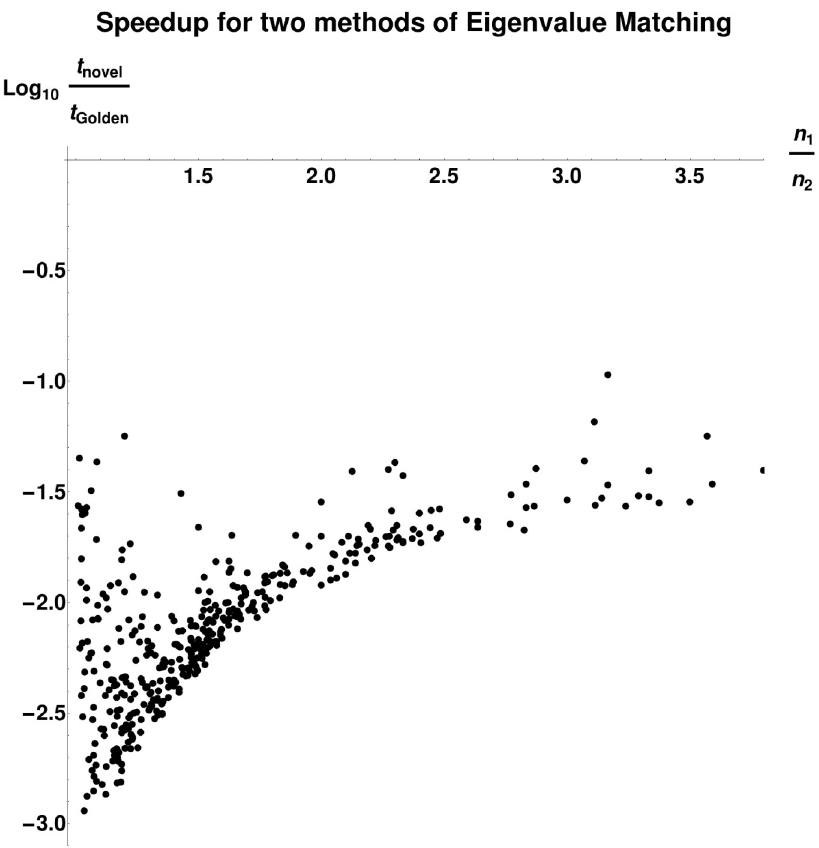
Fig 7. Comparison of runtimes for our algorithm and bounded golden section search over the same interval [10 − 6 , 10]. Runtimes were measured by a weighted count of evaluations of the Linear Assignment Problem solver, with an n × n linear assignment problem counted as n 3 units of cost. Because our algorithm recovers the entire lower convex hull of the objective function as a function of α , we compute the cost of the golden section search as the summed cost of multiple searches, starting from an interval bracketing each local optimum found by our algorithm. We see that our algorithm is much less computationally expensive, sometimes by a factor of 10 3 . The most dramatic speedup occurs in the regime where n 1 � n 2 . Graphs were generated by drawing n 1 uniformly from [5, 120], drawing n 2 uniformly from [ n 1 , n 1 + 60], and then adding edges according to a Bernoulli distribution with p in {.125, .25, .375, .5, .625, .75, .875 } (60 trials each). the triangle inequality is satisfied or not satisfied. We generate triplets G , G , G of random 1 2 3 graphs of sizes n for n 2 [5, 30], n 2 [ n , n + 30], and n 2 [ n , n + 30] by drawing edges 1 2 1 1 3 2 2 i